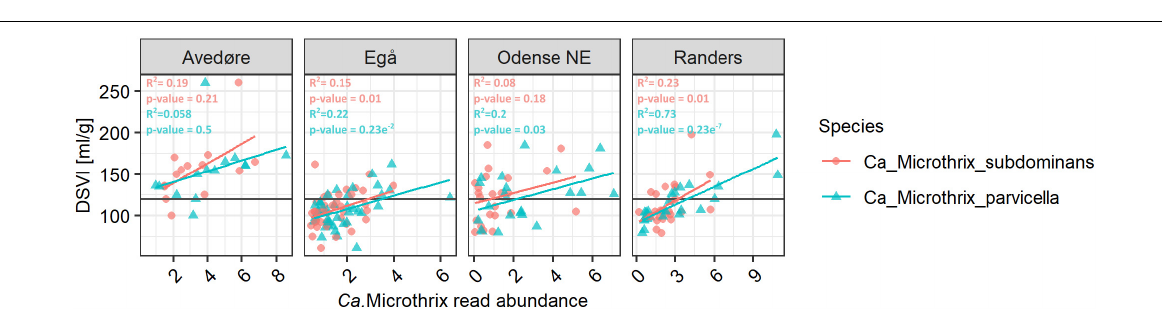
FIGURE 2 | Occurrence of Ca. Microthrix species across (A) different seasons in Denmark, and across the world in relation to (B) temperature (C) continents, (D) process types, and (E) in WWTPs with different fractions of industrial wastewater. The non-parametric Kruskal-Wallis test was used to determine the statistical support for differences between the means of the groupings. The Danish dataset containing 712 samples from 20 WWTPs sampled in the period 2006–2018 (Nierychlo et al., 2020a) was used to visualize seasonal differences in Ca. Microthrix species occurrence.